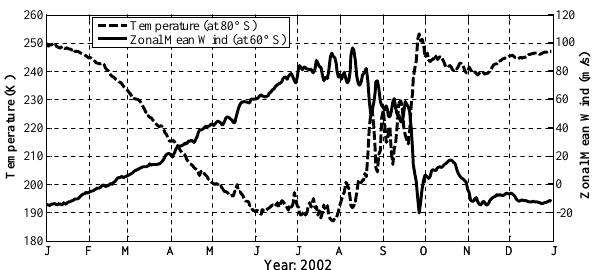
Fig. 1. 2002 records of daily zonal mean wind at 60°S (solid line) and temperature at 80° S (dotted line) from NCEP reanalysis.